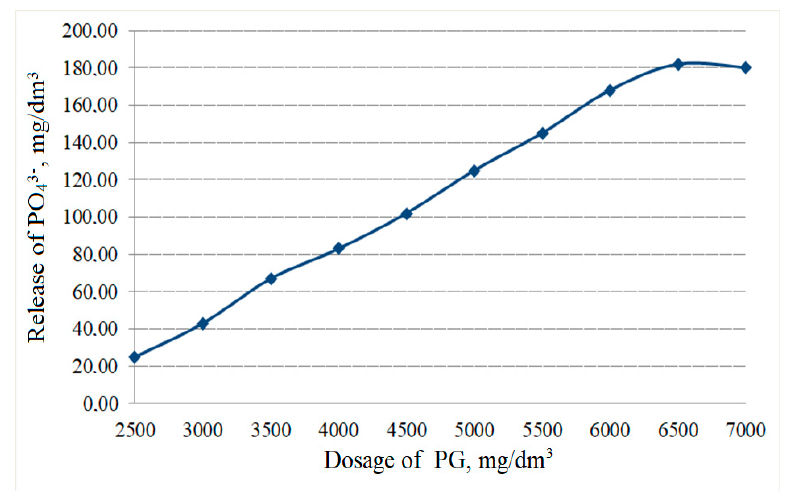
Figure 9. The relationship between phosphates release and the dosage of phosphogypsum (PG) under sulphate-reducing conditions.